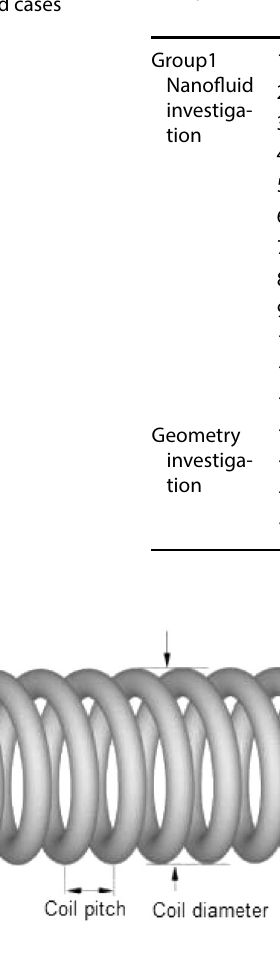
Table 3 Dimension details of sixteen investigated cases